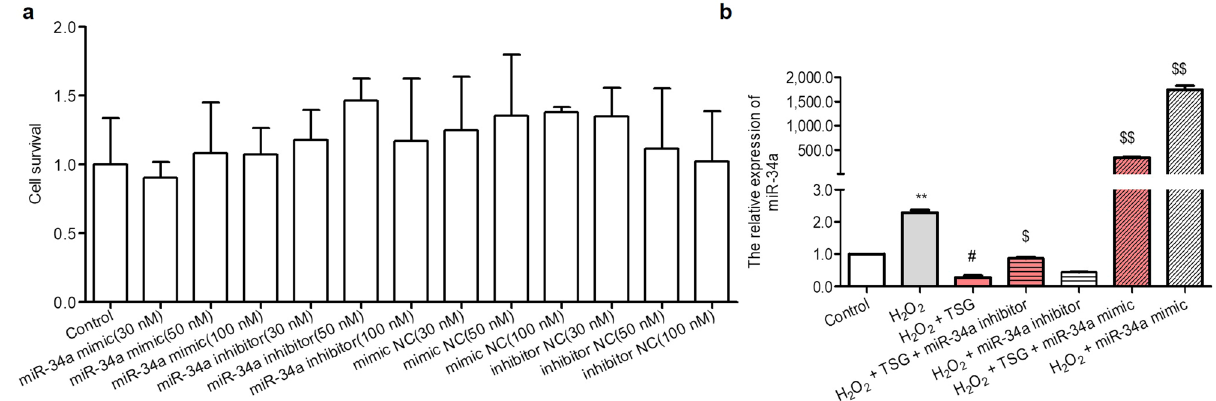
Figure 2. The effect of TSG on the expression level of miRNA-34a in H 2 O 2 -induced HUVECs when over- expression or suppression of miR-34a. ( a ) Effects of different concentrations of the miR-34a mimic or the miR- 34a inhibitor and their negative control (mimic NC, inhibitor NC) on the percentage of cell viability in normal HUVECs. Cell viability was detected by the MTS assay. ( b ) HUVECs were transfected with miR-34a mimic or miR-34a inhibitor for 24 h, then treated with TSG 24 h, H 2 O 2 was added and incubated for 2 h. Total RNA was extracted and the level of miR-34a was detected by qRT-PCR. Results are expressed as the means ± SD. ** p < 0.01